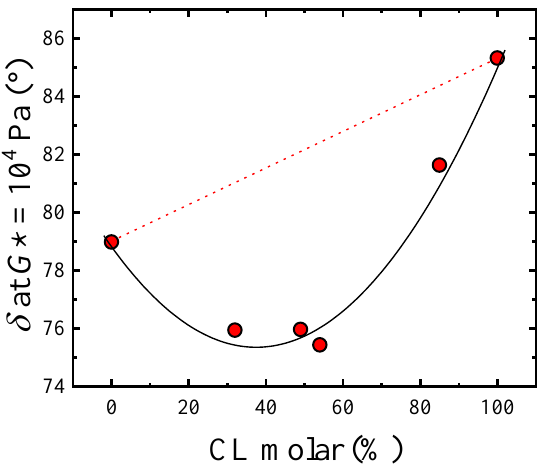
Figure 6. Phase angle δ read from Figure 5 as a function of PBS- ran -PCL copolymer composition. The dotted line represents the linear variation of δ with composition (additive rule). The solid line is a guide to the eye. The respective molecular weight polydispersity indexes of the samples are: P.I. (PBS) = 2.2, P.I. (BS 68 CL 32 ) = 2.7, P.I. (BS 51 CL 49 ) = 3.8, P.I. (BS 46 CL 54 ) = 2.3, P.I. (BS 15 CL 85 ) = 2.0, P.I. (PCL) = 1.9.